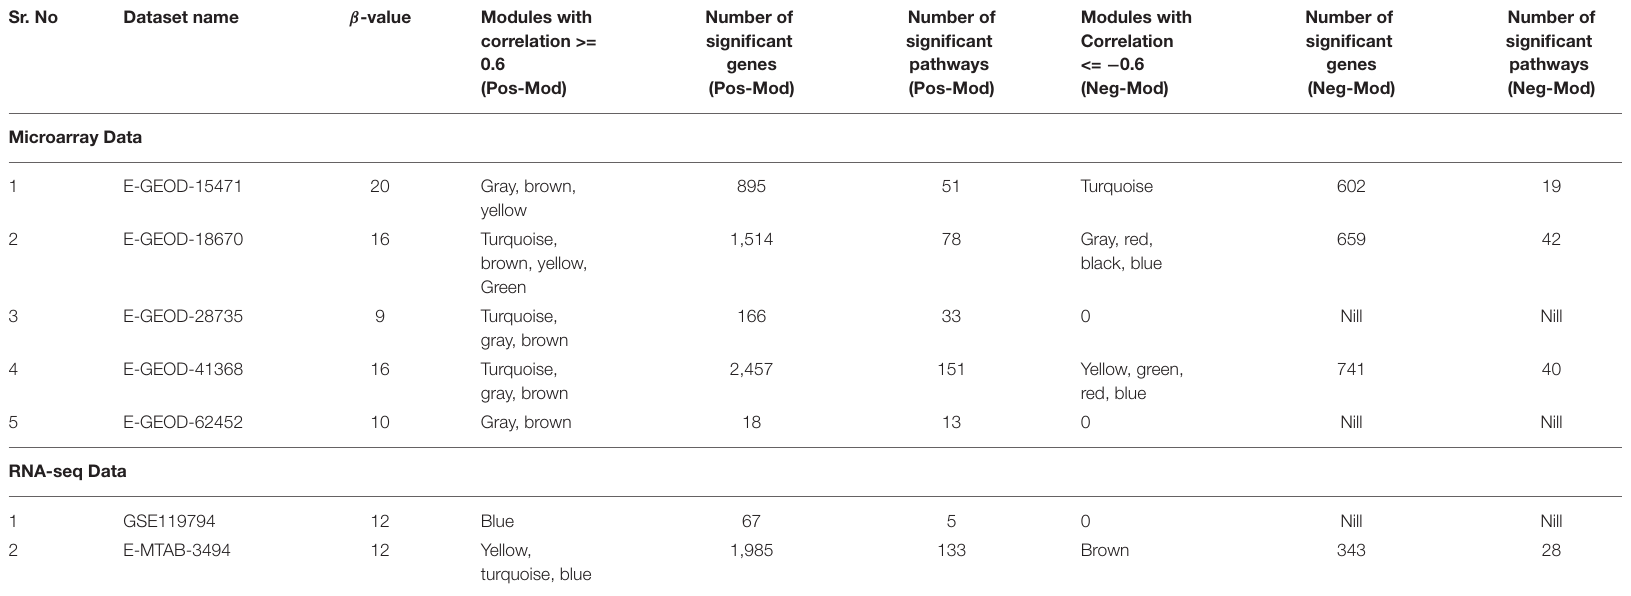
The third column consist of soft threshold value used for calculating adjacency matrix, and forth and seventh column show the names of modules choosed for further analysis. Remaining column contain information of genes selected and significant pathways retrieved for all